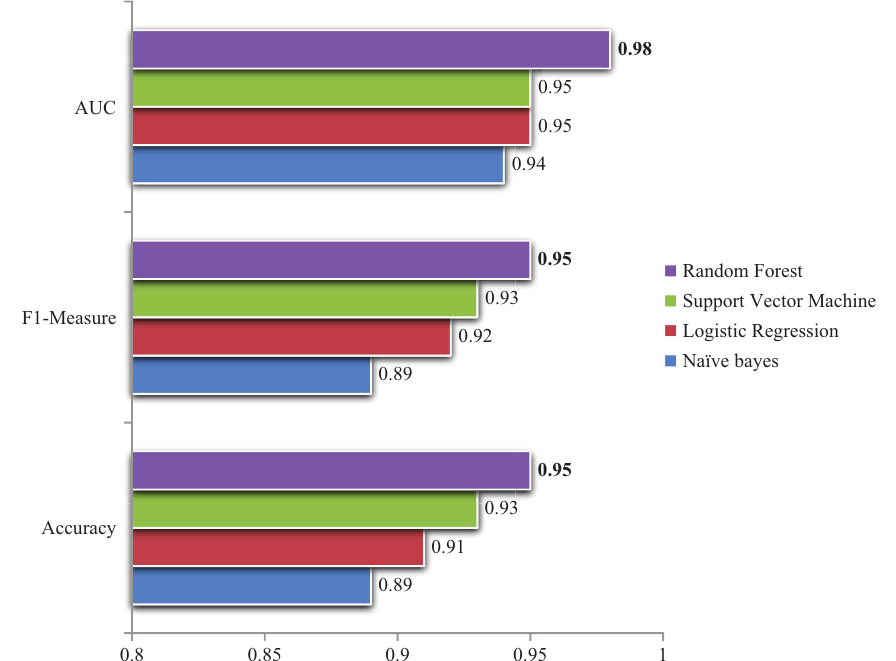
Fig. 7. Comparison of classifiers’ performance for prediction of learner motivation